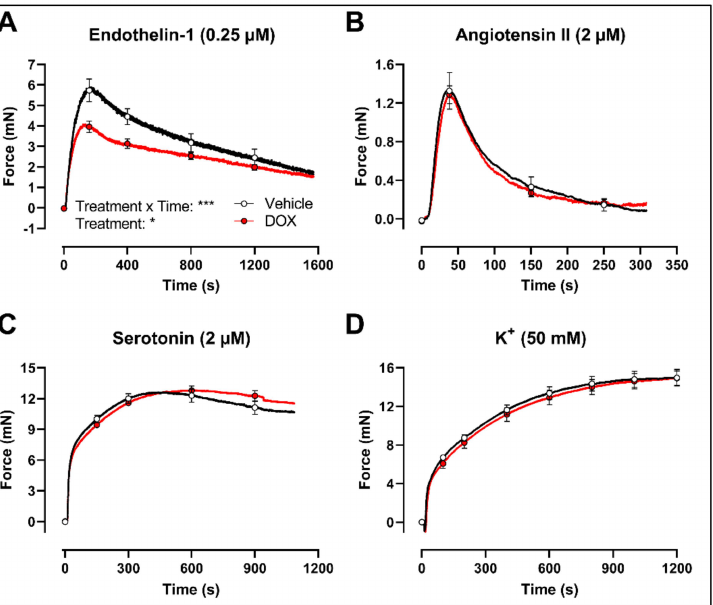
Figure 5. Contraction of aortic segments with endothelin-1, angiotensin II, serotonin and K + after 16 h of ex vivo DOX treatment. DOX decreased VSMC contraction in response to 0.25 µ M endothelin-1 ( A ) but not after stimulation with 2 µ M angiotensin II ( B ), 2 µ M serotonin ( C ) and 50 mM K + ( D ). For ( A – D ), repeated measures two-way ANOVA with Šid à k’s multiple comparisons test. *, *** p < 0.05, 0.001; p > 0.05 in ( B – D ); For ( A – C ), n = 6 in each group; for ( D ), n = 10 in each